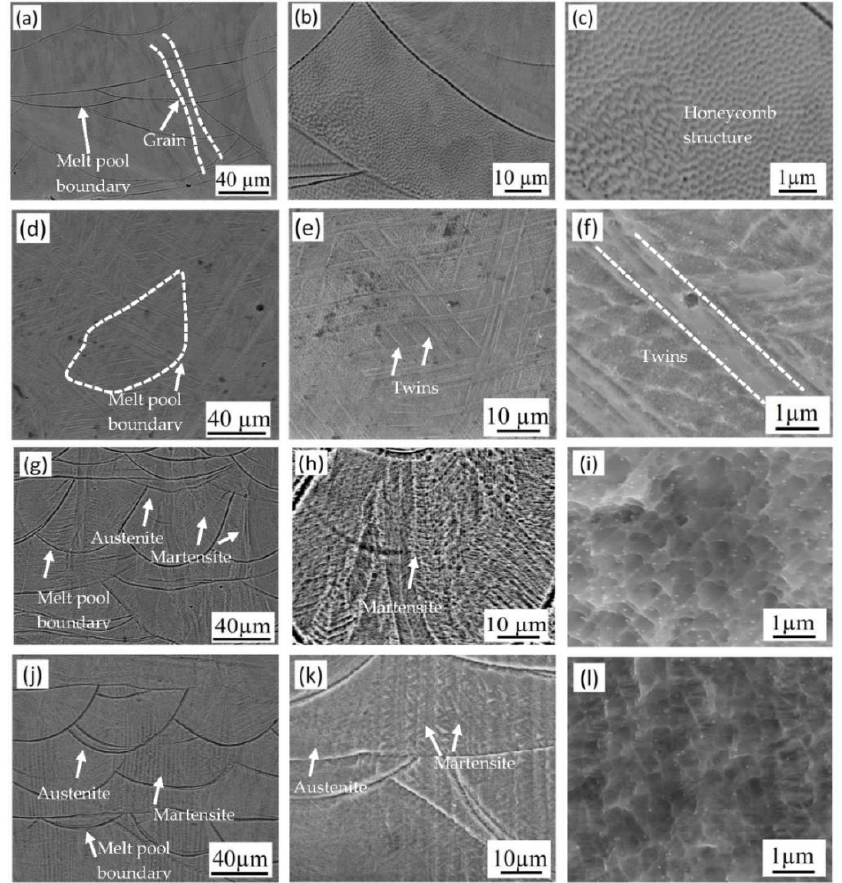
Figure 3. SEM images of 316 L stainless steel: ( a – c ) as-built specimen 5, ( d – f ) room temperature specimen 1, ( g – i ) −196 °C specimen 3, and ( j – l ) −196 °C specimen 4 after electrolytic etching with oxalic acid.